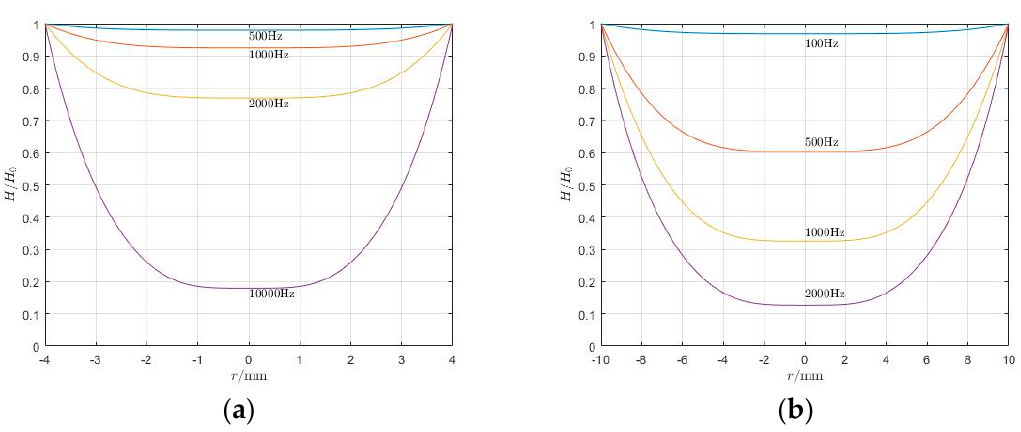
Figure 8. Magnetic field intensity distribution inside the GMM rod. ( a ) r = 4 mm, ( b ) r = 10 mm. When the GMM rod is in an alternating magnetic field, due to the eddy current e ff ect, the relative magnetic field strength of the GMM rod decreases, that is, there is a part in the GMM that greater the attenuation of the magnetic field. Moreover, GMM rods with different rod diameters have different blocking effects on high-frequency magnetic fields. The thicker the GMM rod (i.e., the larger the radius), the stronger the attenuation at the same frequency.